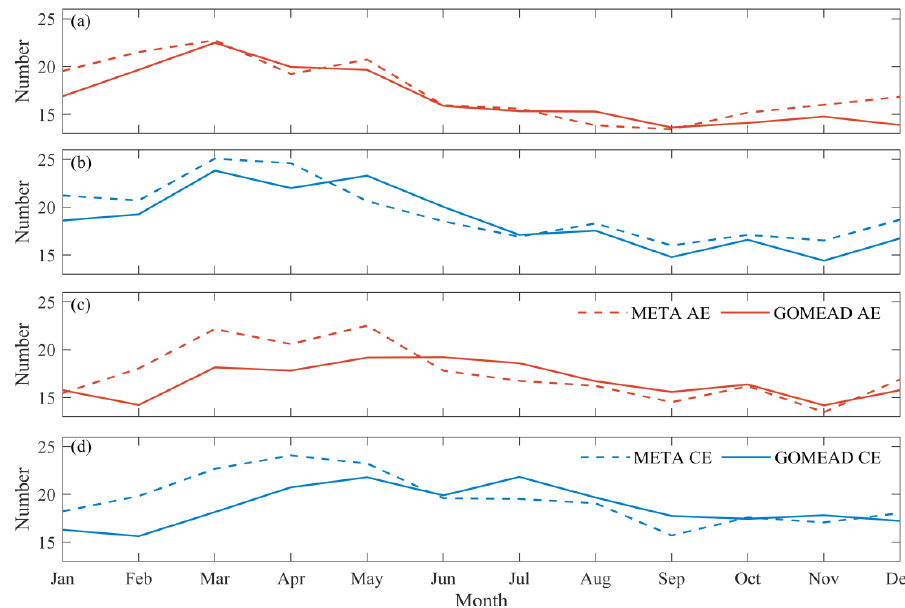
Figure 7. Same as Figure 6, but for seasonal variation. Figure 7. Seasonal variation of the number of generated ( a ) AEs and ( b ) CEs and with the correspond- ing terminated ( c ) AEs and ( d ) CEs in the SF